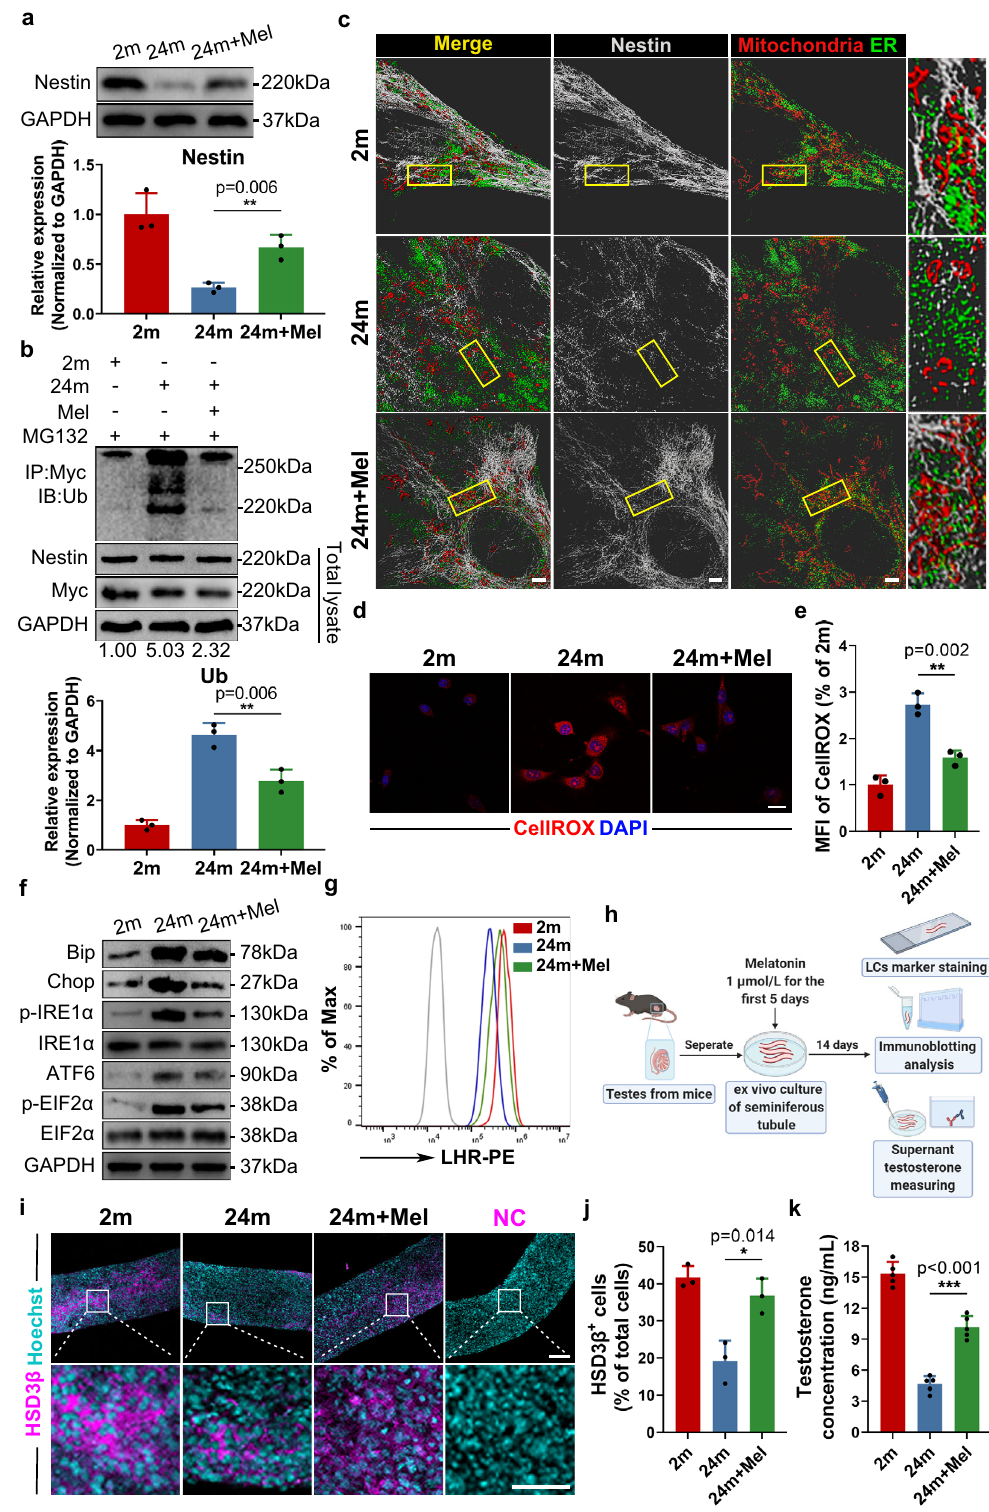
LC differentiation of Nes-GFP + cells in vitro . Nes-GFP + cells were cultured in fresh differentiation-inducing medium containing phenol red-free DMEM/F12 and M199 medium (1:1; Gibco), 2% FBS, 10 ng/ml PDGFAA (PeproTech), 1ng/ml LH (R&D Systems), 250 nM Smoothened Agonist HCl (SAG; Millipore), 1 μ M For- skolin (Fsk; Sigma-Aldrich), 50 ng/ml insulin-like growth factor 1 (IGF1, Pepro- Tech), and 5 μ g/L insulin-transferrin-sodium selenite (Sigma), and they were incubated for 14 days 15 .